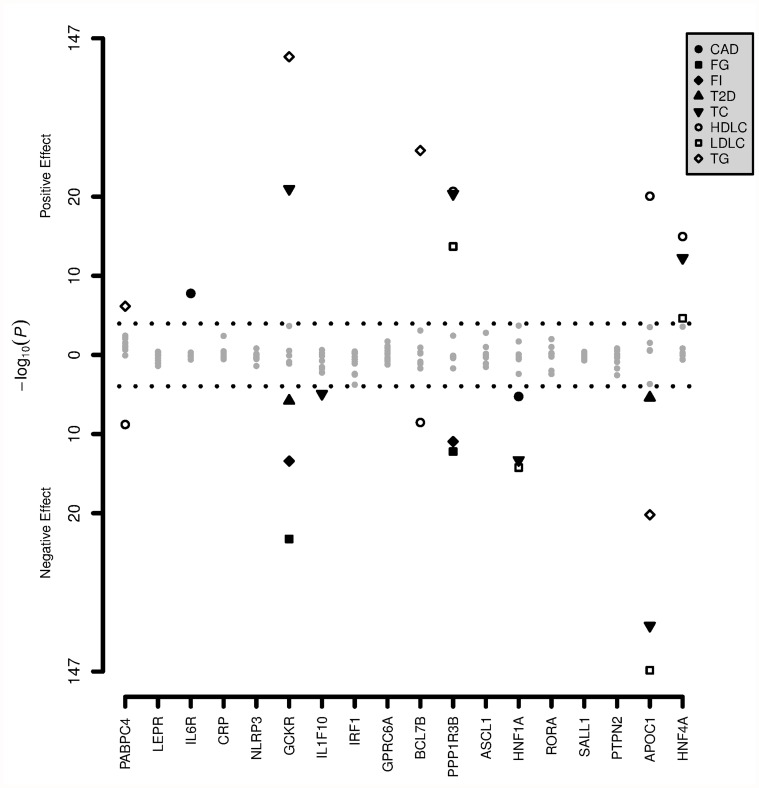
P-values for the associations of the 18 CRP SNPs with different cardiometabolic phenotypes.P-values for the associations between the 18 CRP SNPs and BMI, lipids, glycemic phenotypes, SBP and coronary artery disease. The genes on the x-axis represent the genes in which the CRP SNPs are located or closest by. The numbers on the y-axis indicate the p-values of the association between the SNPs and the cardiometabolic phenotypes. Significant associations are colored as depicted in the figure legend. For BMI and SBP, no significant associations were observed. CAD, coronary artery disease; FG, fasting glucose; FI, fasting insulin; HDLC, HDL-cholesterol; LDLC, LDL-cholesterol; T2D, type 2 diabetes; TC, total cholesterol; TG, Triglycerides.